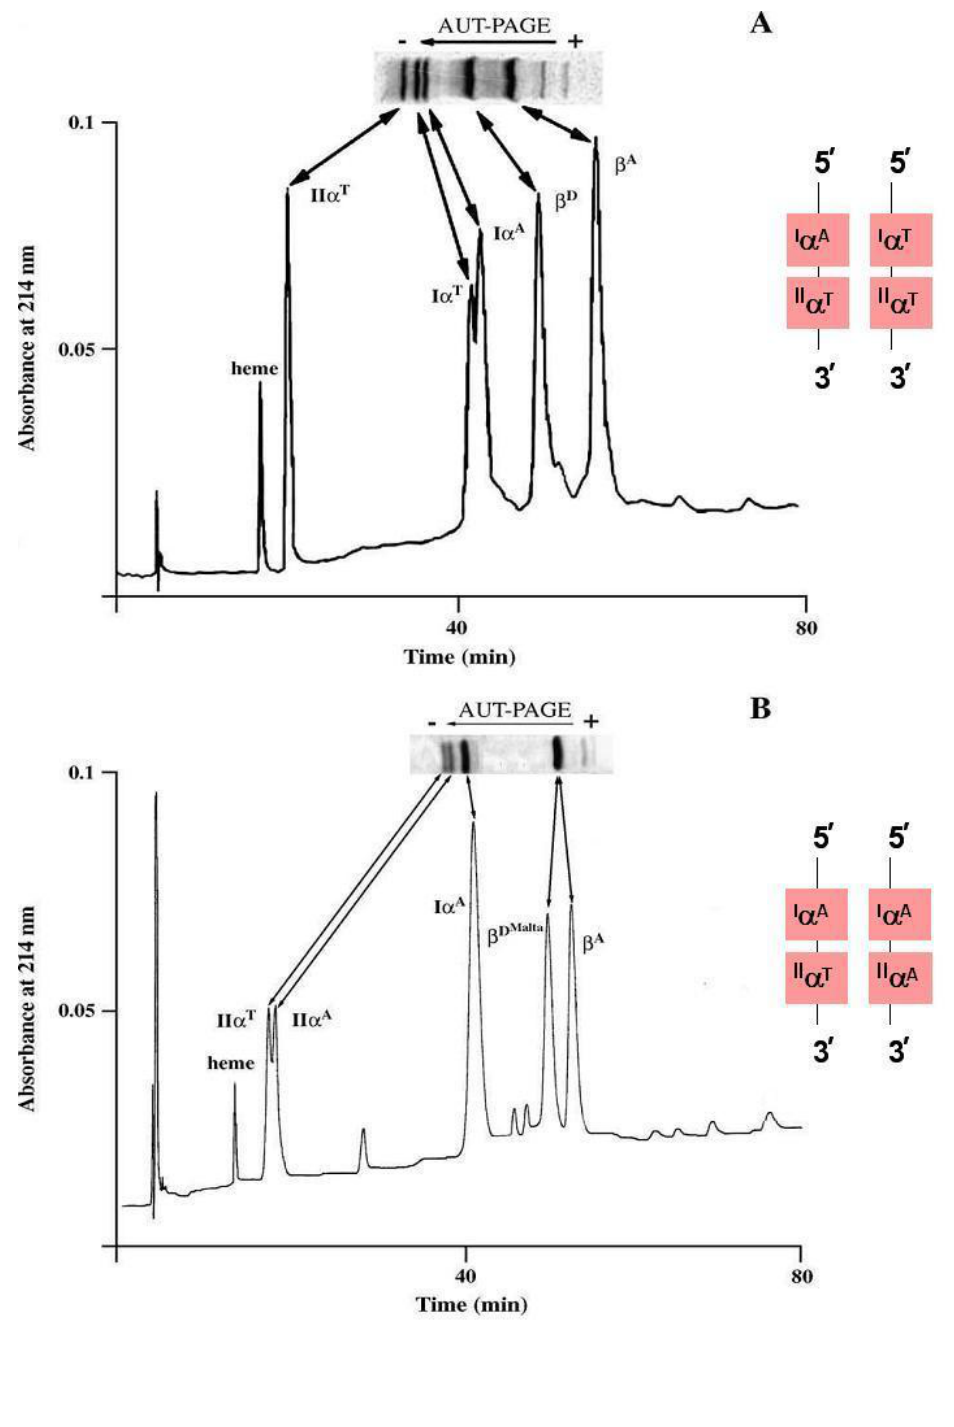
Figure 5. AUT-PAGE and HPLC specific chromatographic profile of alpha and beta globin variants in goats. Panel A : one non allelic alpha globin ( II α A ), two allelic alpha globins ( I α A and I α T ) and two beta globins (β A and β D ); panel B , two allelic alpha globins ( II α T and II α A ), a non allelic alpha ( I α A ) and two beta (β A and β DMalta ). The relative alpha globin gene arrangements are shown on the